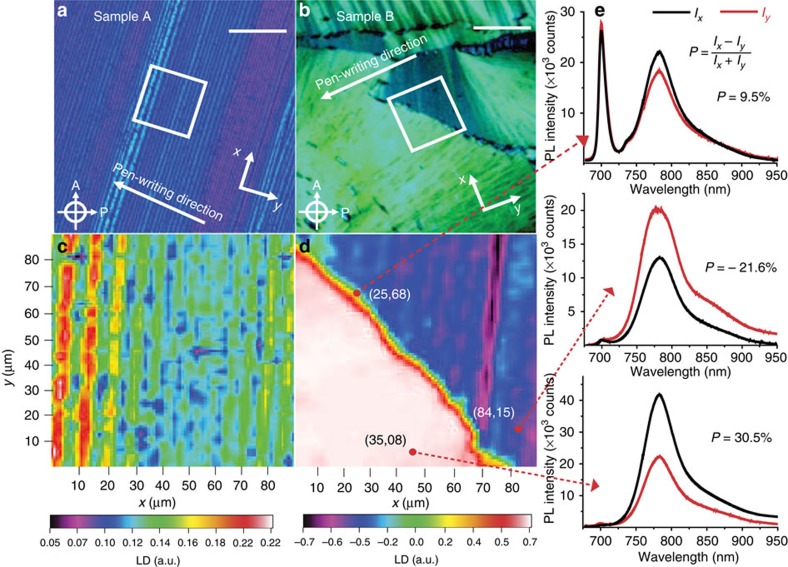
LD/PL microscopy of electronic states at the grain boundaries.(a,b) Standard polarization-mode microscopy images of two distinct polycrystalline H2Pc-OC8 films: sample A (0.1% solution, 2 mm s−1) and sample B (1% solution, 20 μm s−1) that reveal very different grain structures. The orientation of pen-writing direction with respect to the polarizer and analyser (x–y) axes is marked with a white arrow. (c,d) High-resolution LD microscopy images of 90 × 90-μm areas identified with a white square in (a,b). (e) polarization and spatial resolved PL spectra of sample B recorded at three distinct locations identified through their (x,y) coordinates. The LD contrast indicates the different orientation of the stacking axis in adjacent grains. Depending on the growth conditions, the grains assemble in stripe-like films with low-angle (∼5°) grain boundaries (sample A (a,c)) or fan-like films with high-angle (∼25°) grain boundaries (sample B (b,d)). An additional monomer-like feature is present at the high-angle grain boundary. Similar spectra are recorded from sample A, but no monomer-like feature is observed at the low-angle grain boundaries.